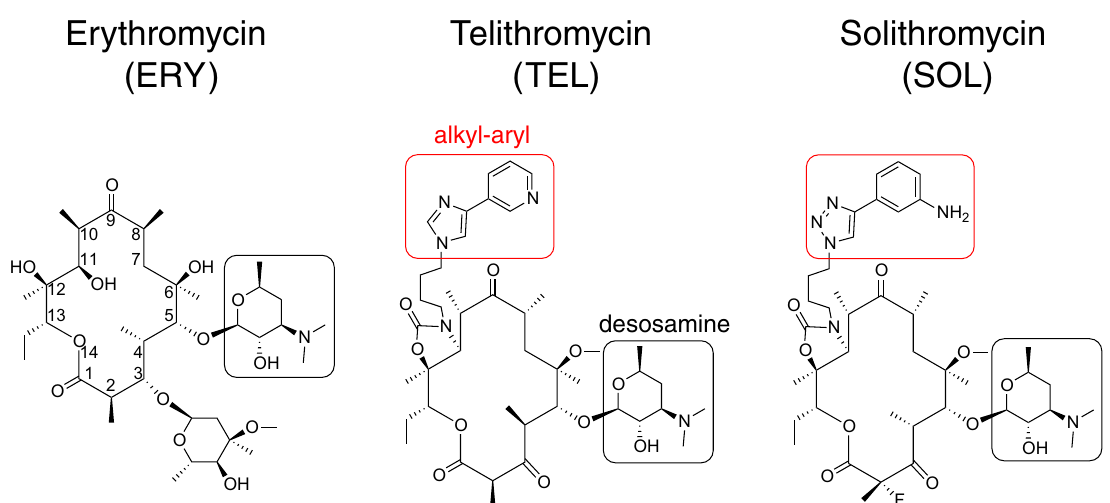
Fig. 1 Macrolide antibiotics. Chemical structures of the main macrolide antibiotics used in this study. The numbering of the macrolactone atoms is shown on the ERY structure. C5-desosamine sugars and alkyl-aryl side chains of the extended macrolides are indicated by black and red rectangles,